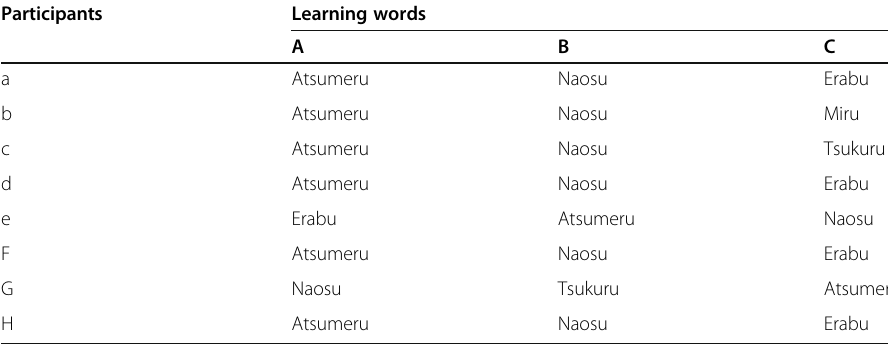
Table 3 Learning words for each